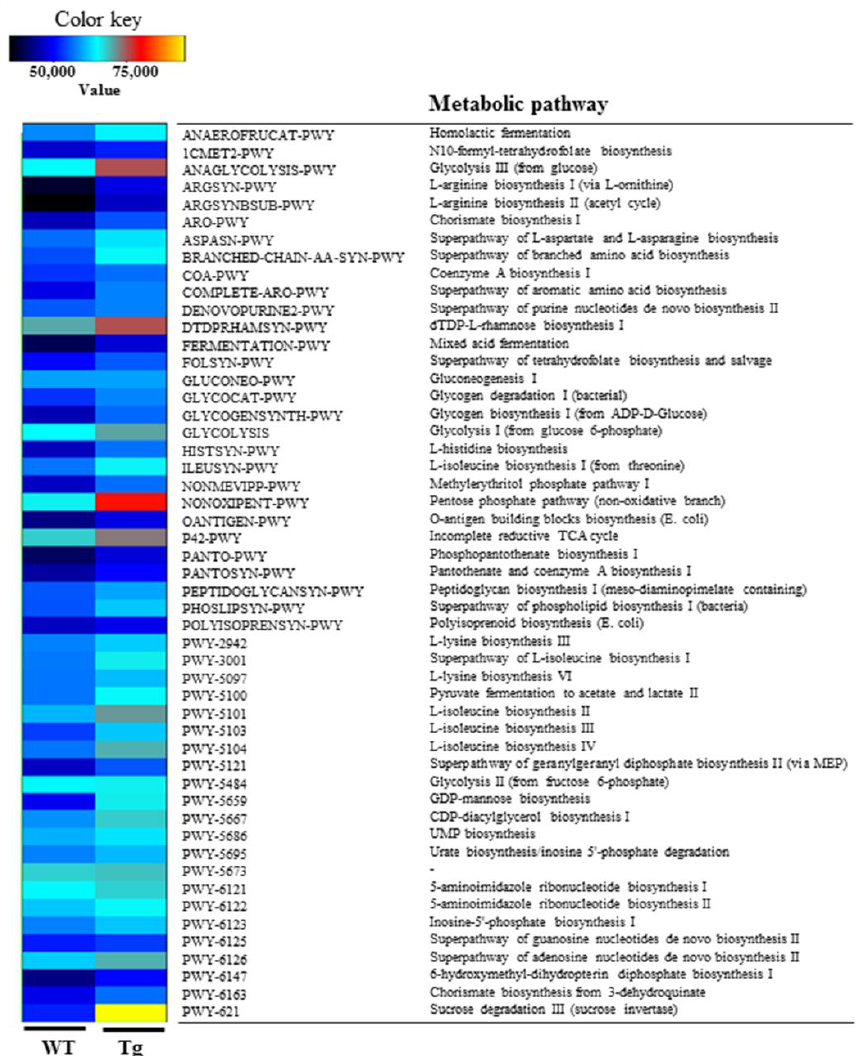
Figure 3. Heat map of the predicted metabolic pathways for the fecal microbiota in Tg2576 mice. This pathway was obtained using the PICRUSt2 (v.2.3.0) software as described in Materials and Methods. Abbreviations: WT, wild-type; Tg, Tg2576 mice.